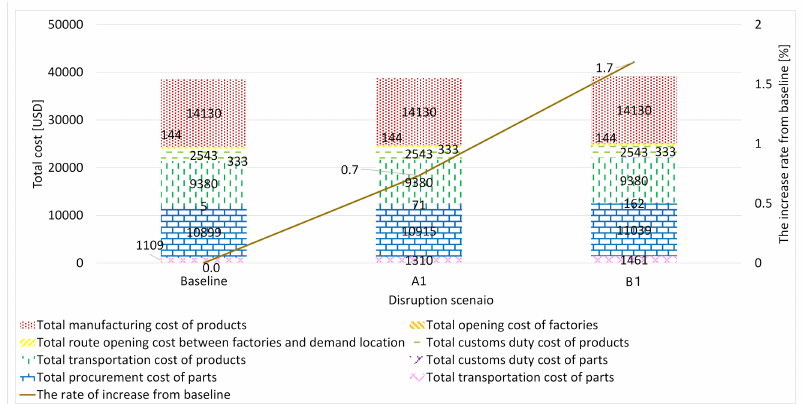
Figure 10. The resulting total costs in the baseline, and in scenarios A1 and